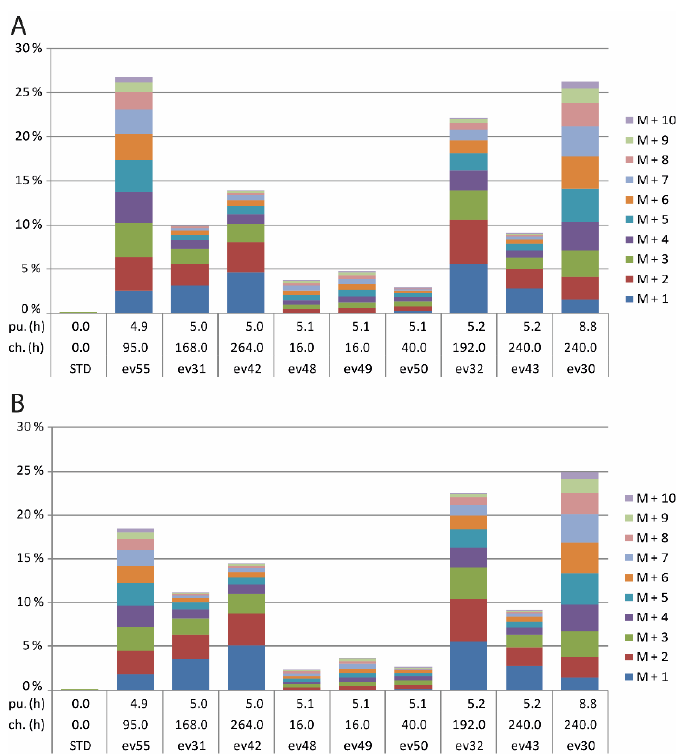
Figure 3. ( A ) Isotopologue excess values and distribution of isotopomers of cineole for selected samples in 13 CO 2 feeding experiments. All experiments are sort according to their chase time in ascending order. pu. (h): pulse time in hours. ch. (h): chase time in hours. STD: pure cineole sample. ( B ) Isotopologue excess values and distribution of isotopomers of camphor for selected samples in 13 CO 2 feeding experiments. All experiments are sort according to their chase time in ascending order. pu. (h): pulse time in hours. ch. (h): chase time in hours. STD: pure camphor sample. Table 1. GC/MS excess data for M+2 and M+3 isotopomeres in 1,8-cineole and camphor extracted with chloroform-d and analyzed by GC/MS from spike lavender leaves at different points of time after the labelling pulse phase with 13 CO 2 . SD: standard deviation.